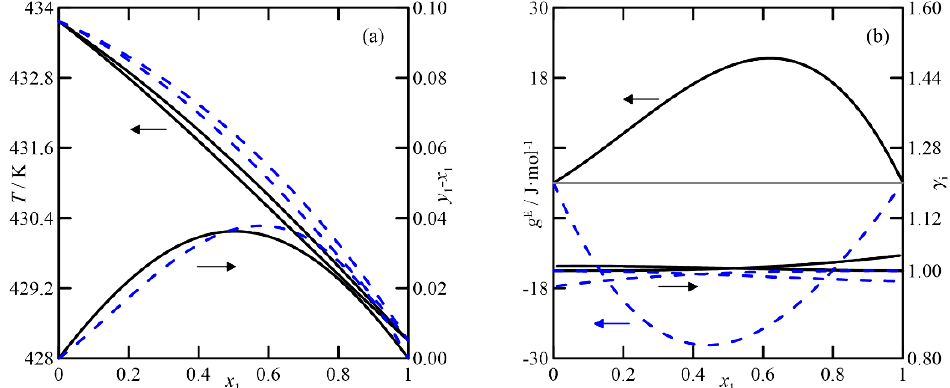
Figure 7. Estimations of VLE at 101.32 kPa of cyclohexanone + cyclohexanol. (----) UNIFAC-DM; (- - -) COSMO-RS. ( a ) T ,x,y and (y − x ), x ( b ) γ i vs x and g E / RT vs x. (iii/iv) Cyclohexanone + (2 or 3)-cyclohexen-1-ol: The VLEs of cyclohexanone with two